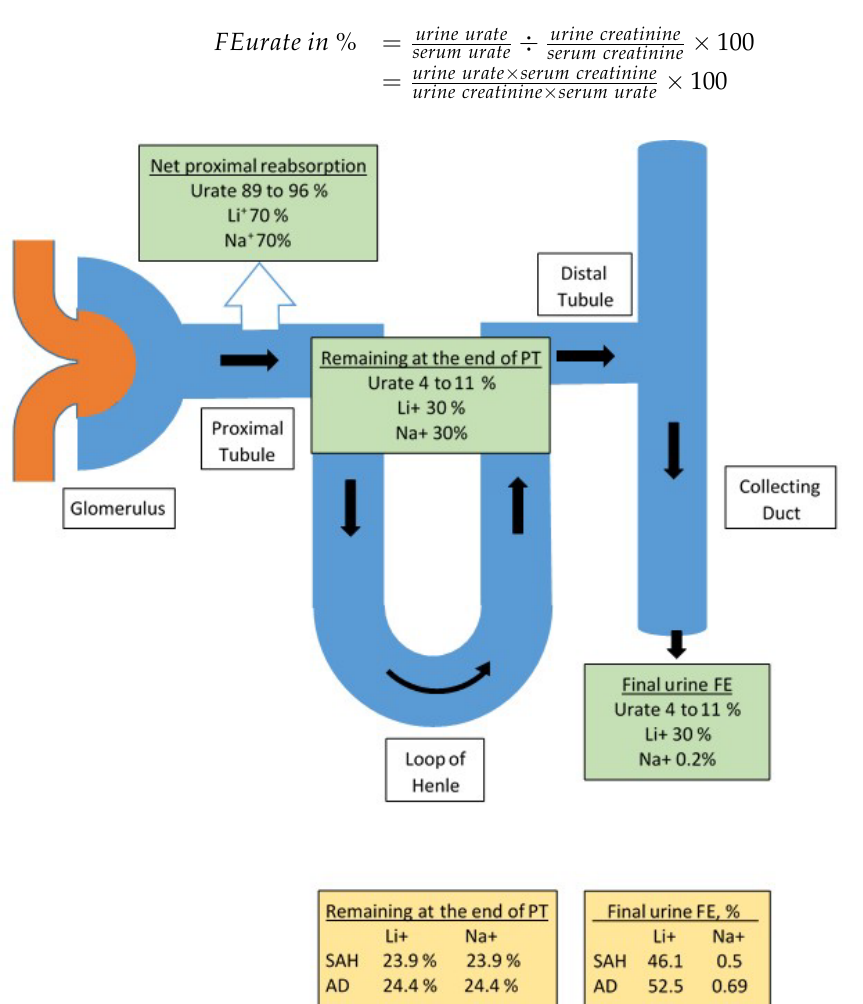
Figure 1. Figure depicting the handling of filtered urate, lithium and sodium by different segments of the renal tubule under normal (green) conditions and after infusion of serum from patients with RSW (yellow): one due to a subarachnoid hemorrhage and another due to Alzheimer’s disease. Net proximal reabsorption represents the percent reabsorption of urate, lithium (Li + ) and sodium (Na + ) in the proximal tubule. Remaining at the end of proximal tubule (PT) represents the percentage of each solutes filtrate entering the early Loop of Henle. Final urine FE represents the net handling of solute expressed as the fraction of filtered solute excreted in the urine. Yellow boxes indicate the percent of the filtered urate, lithium and sodium remaining at the end of the proximal tubule and in the final urine when rats were injected with serum of a patient with a subarachnoid hemorrhage (SAH) and another with Alzheimer’s disease (AD). Note the identical amount of sodium and lithium leaving the proximal tubule and how sodium is much lower than lithium in the final urine because sodium is reabsorbed by the distal tubule but not